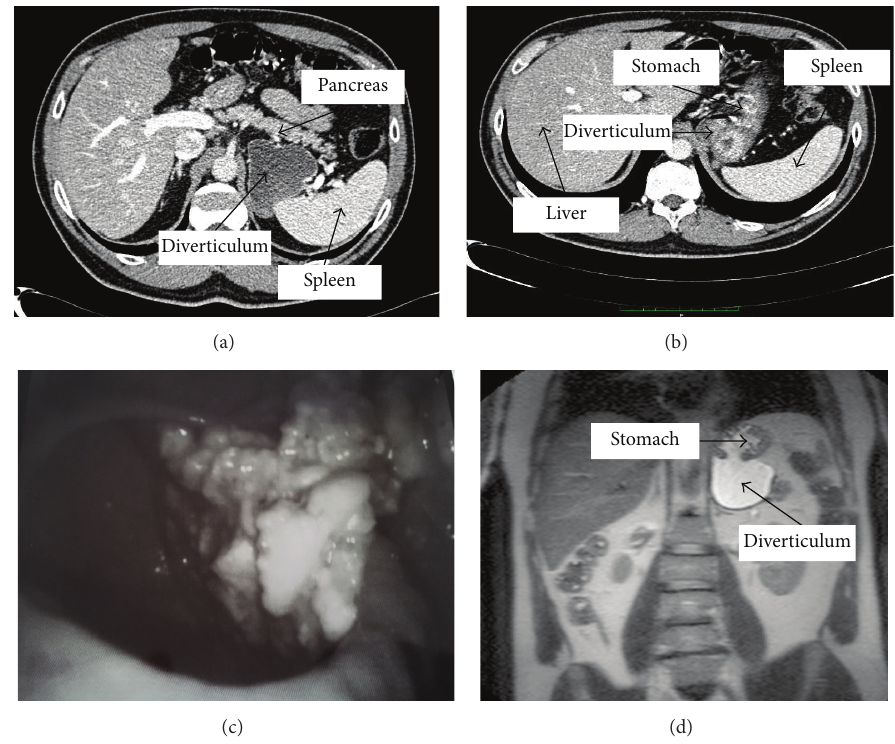
Figure 2: Arterial phase CT scan, transverse planes (a-b). Endoscopic image of a large diverticular neck (30 × 20 millimeters) situated in the posterior wall of the gastric fundus, with the pouch partially filled by undigested food (c). T2-weighted MRI image